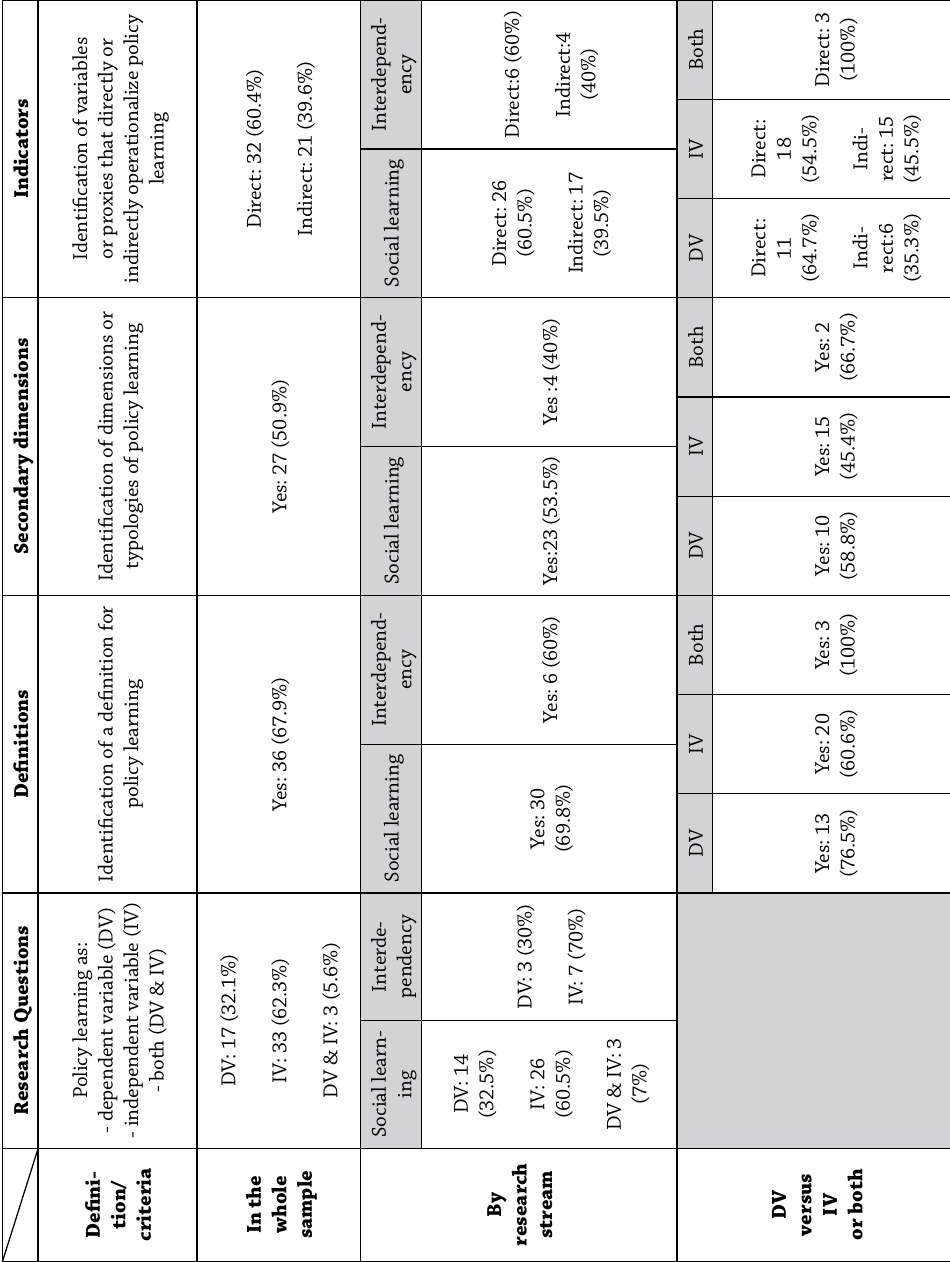
Table 2a: Results of the systematic literature